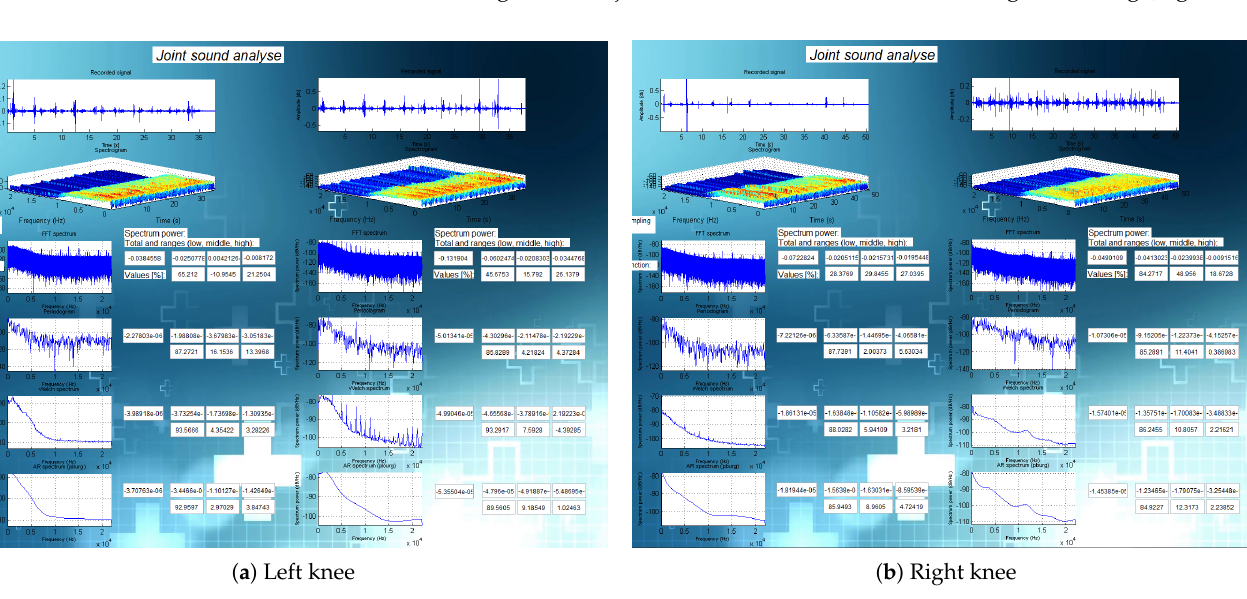
Figure A6. Analysis for subject 6. 7.